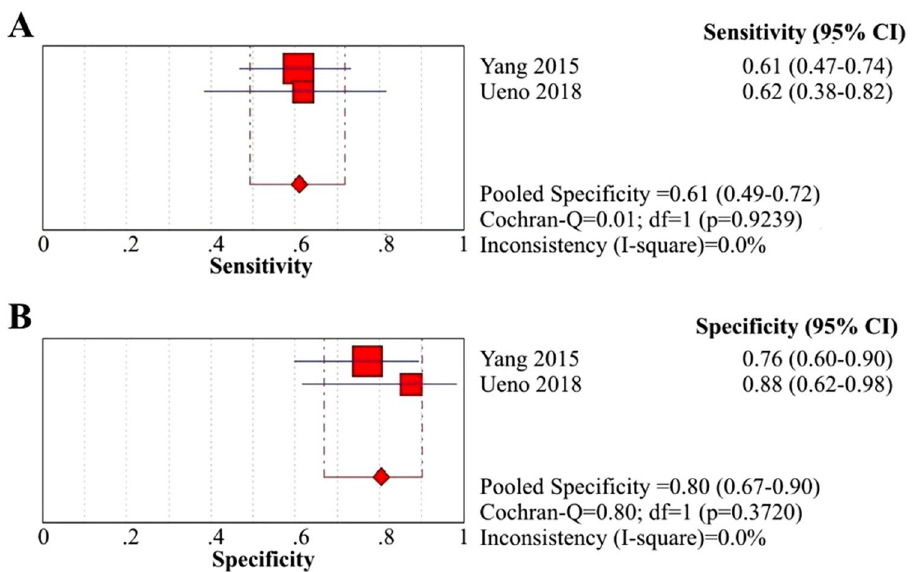
Figure 6. Coupled forest plots of the sensitivity and specificity of APRi for post-KPE significant liver fibrosis and cirrhosis. ( A ) Sensitivity of APRi for significant fibrosis; ( B ) Specificity of APRi for significant